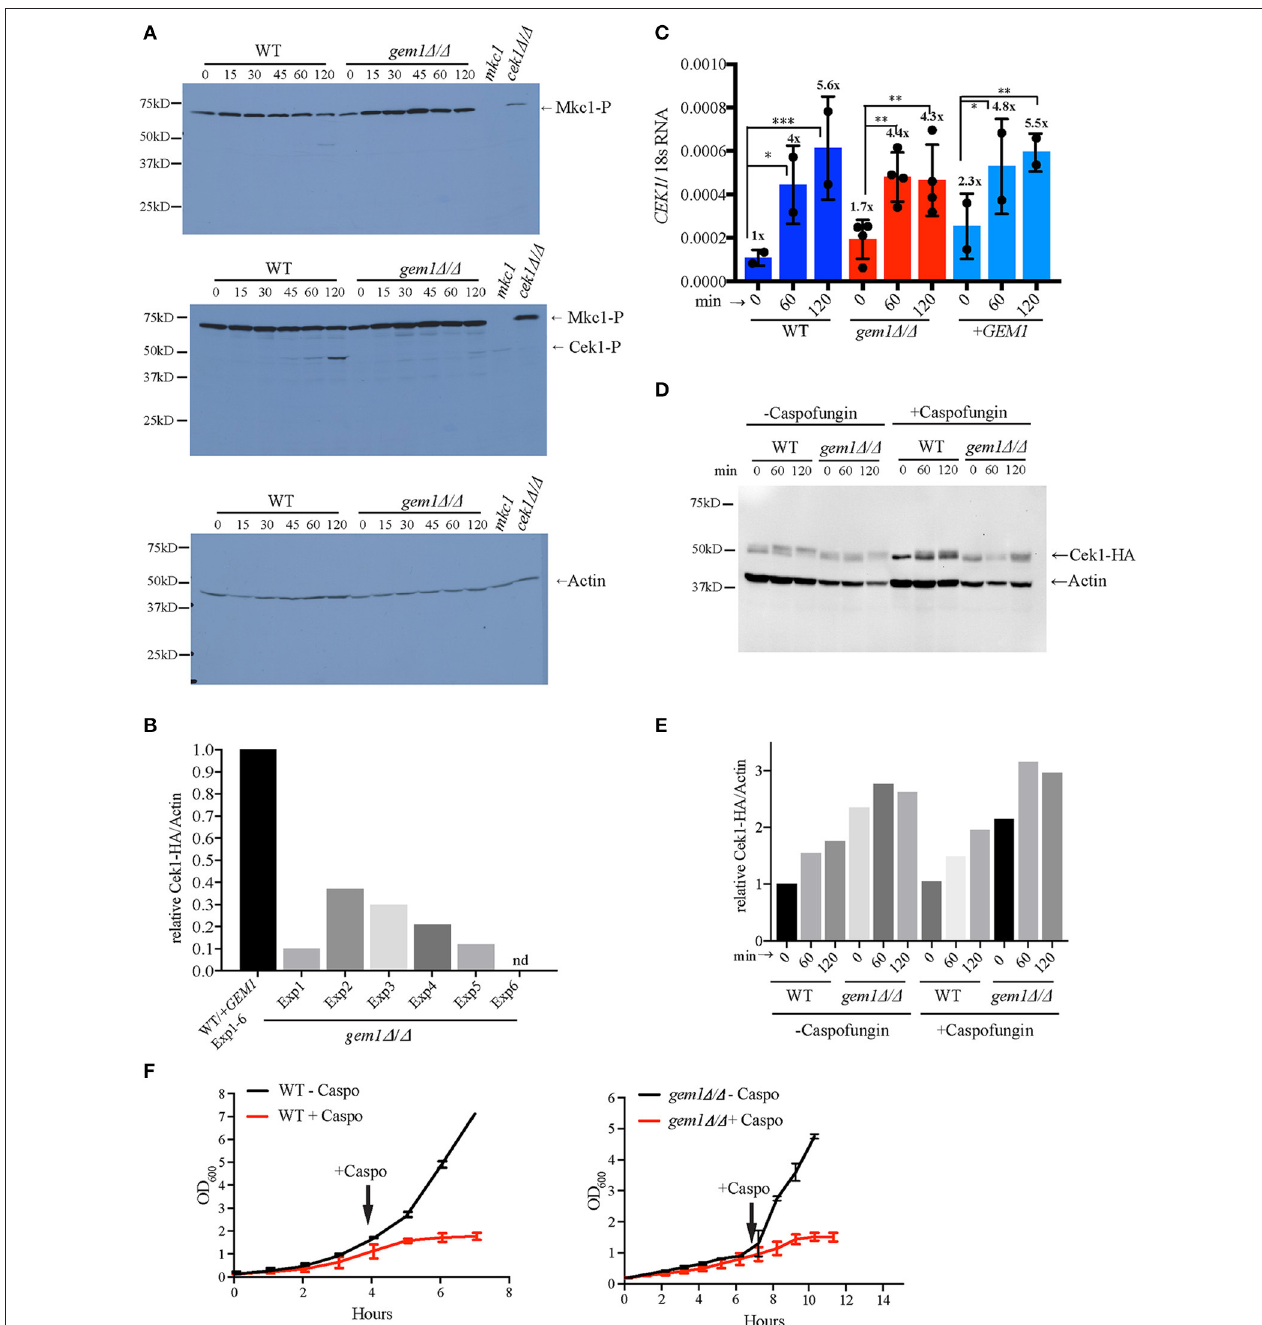
FIGURE 3 | Gem1 is required for activation of the Cek1-dependent cell wall stress pathway. (A) Cells were grown in YPD to early log phase and then treated with 125ng/ml caspofungin for the indicated times. The mkc1 and cek1 mutant samples are from cultures treated with caspofungin for 2h. Phospho-Mkc1 and phospho-Cek1 were detected using the anti-phospho Erk antibody (p-44/42). The top and middle panel are from the same membrane—top: short exposure to avoid saturation of the phospho-Mkc1 signal; middle: longer exposure of the same membrane to obtain the phospho-Cek1 signal. Actin was used as the loading control. (B) The phospho-Cek1 signal from wild type and gem1 1 / 1 mutant and was quantified at 120min post caspofungin treatment, and normalized to the signal for actin as the loading control. Quantification was performed as described in the section Materials and Methods. The normalized phospho-Cek1/Act1 ratios in the mutant were expressed relative to the wild type, which was set to 1. Five independent experiments were analyzed. The primary data used for these quantifications are shown in Figure 3A and Figure S3 . (C) Expression levels of CEK1 mRNA were monitored by quantitative PCR at the indicated time points after caspofungin treatment. 18S RNA was used for normalization. Cells were grown as described in (A) . Shown are results from two independent experiments (average and standard deviation). In each of the experiments, two independent gem1 1 / 1 mutant clones were used (therefore, for the mutant n = 4). The numbers above the graph represent fold up-regulation